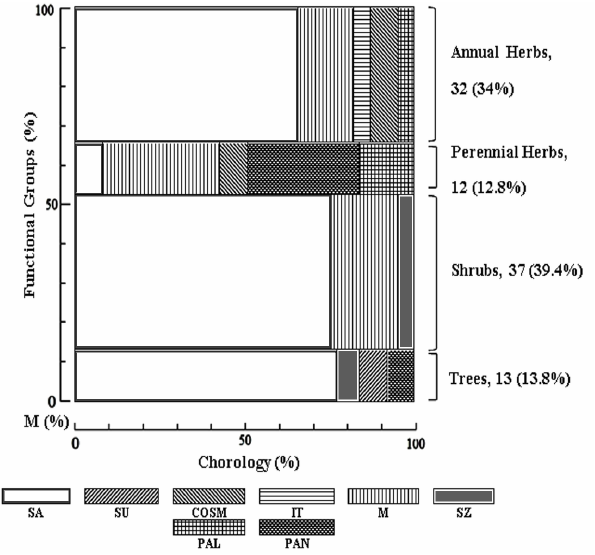
Fig. 2. Chorotype spectrum and functional groups diagram of the study area. M= species magnitude and average group